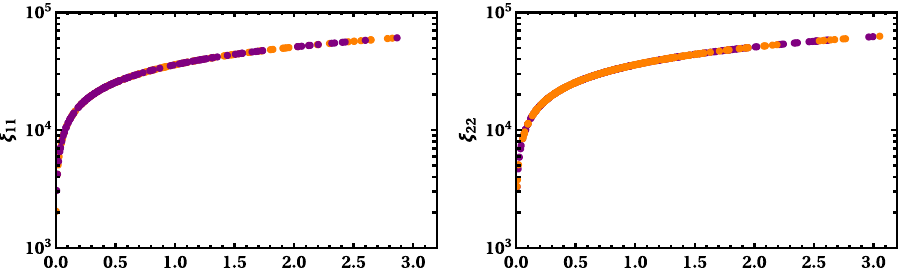
Fig. 1 The scanned points plotted for Scenario-I (Scenario-II) in η eff – ξ 11 ( η eff – ξ 22 ) plane in the left panel (right panel) respectively. The purple and orange scanned points are respectively for c χ